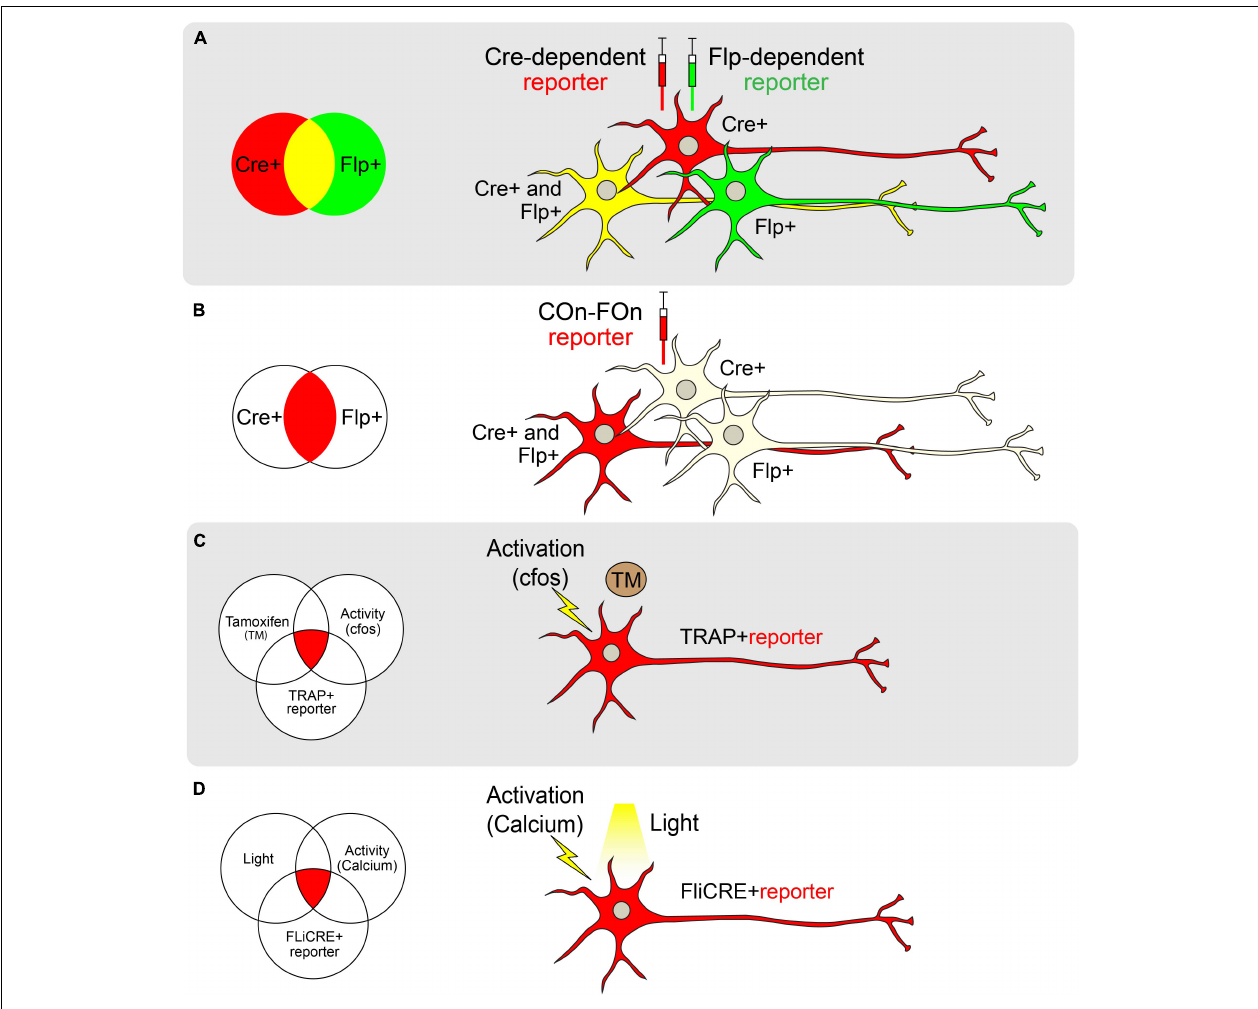
FIGURE 2 | Genetic approaches toward achieving cell-type specificity. (A) Schematic of labeling neurons with different reporters using Cre (red) and Flp (green) recombinases separately. Cre and Flp-positive cells are visualized in yellow. (B) Schematic of labeling neurons with both Cre and Flp recombinases using the Con-Fon reporter, which is designed to be expressed only when both Cre and Flp recombinases exist. (C) Schematic of TRAP. The reporter of interest will be expressed only when Tamoxifen (TM) and neural activity (as indicated by cfos expression) exist in a TRAP + neuron. (D) Schematic of FLiCRE. When light and neuronal activity (as measured by an increase in calcium concentration) exist simultaneously, neurons will express the FLiCRE reporter of interest.